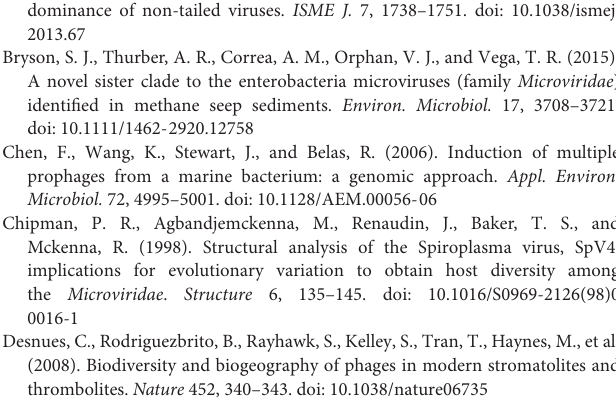
FIGURE S2 | Unrooted maximum-likelihood phylogenetic tree based on the inferred amino-acid sequences of full-length replication initiator in Microviridae genomes. Bootstrap percentages from 100-replicate maximum-likelihood trees are shown. The scale bar represents a distance of 0.2 substitutions per